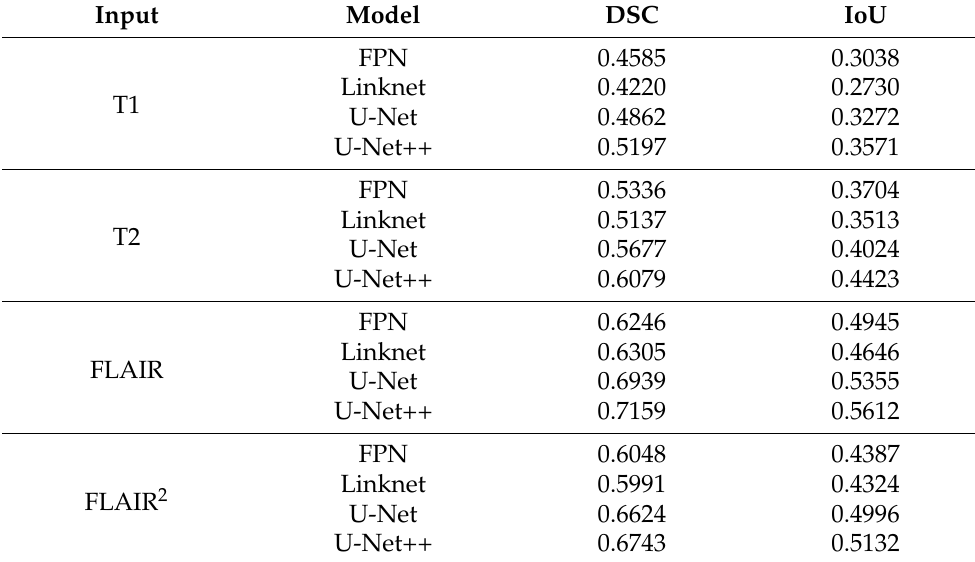
Table 6. Testing metrics using combined